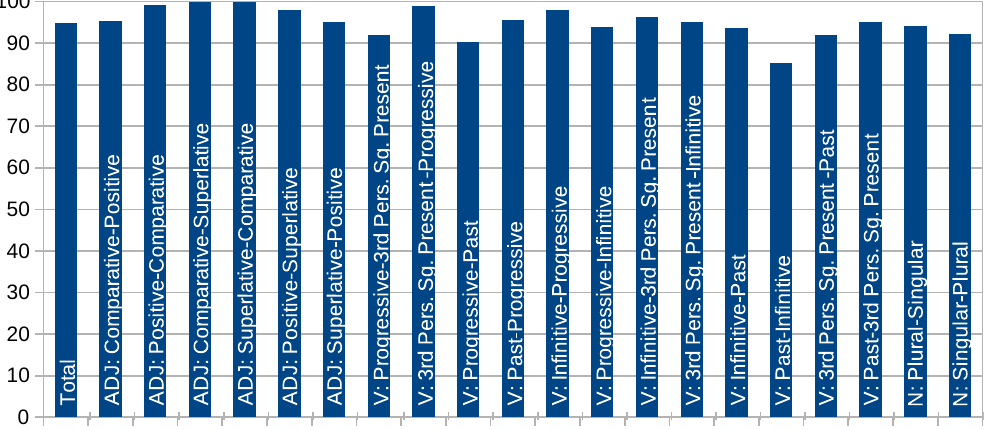
Figure 6: Results for all relations (total), and for each specific relation of the English test